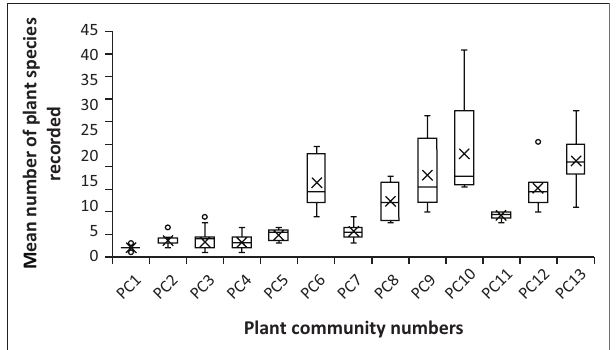
FIGURE 4: Species richness for the 13 plant communities of the uMlalazi Nature